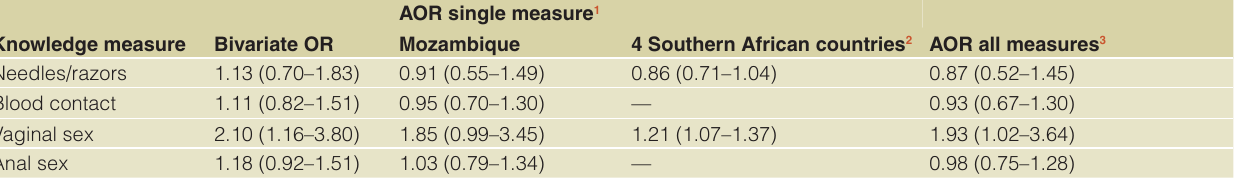
Knowledge measure